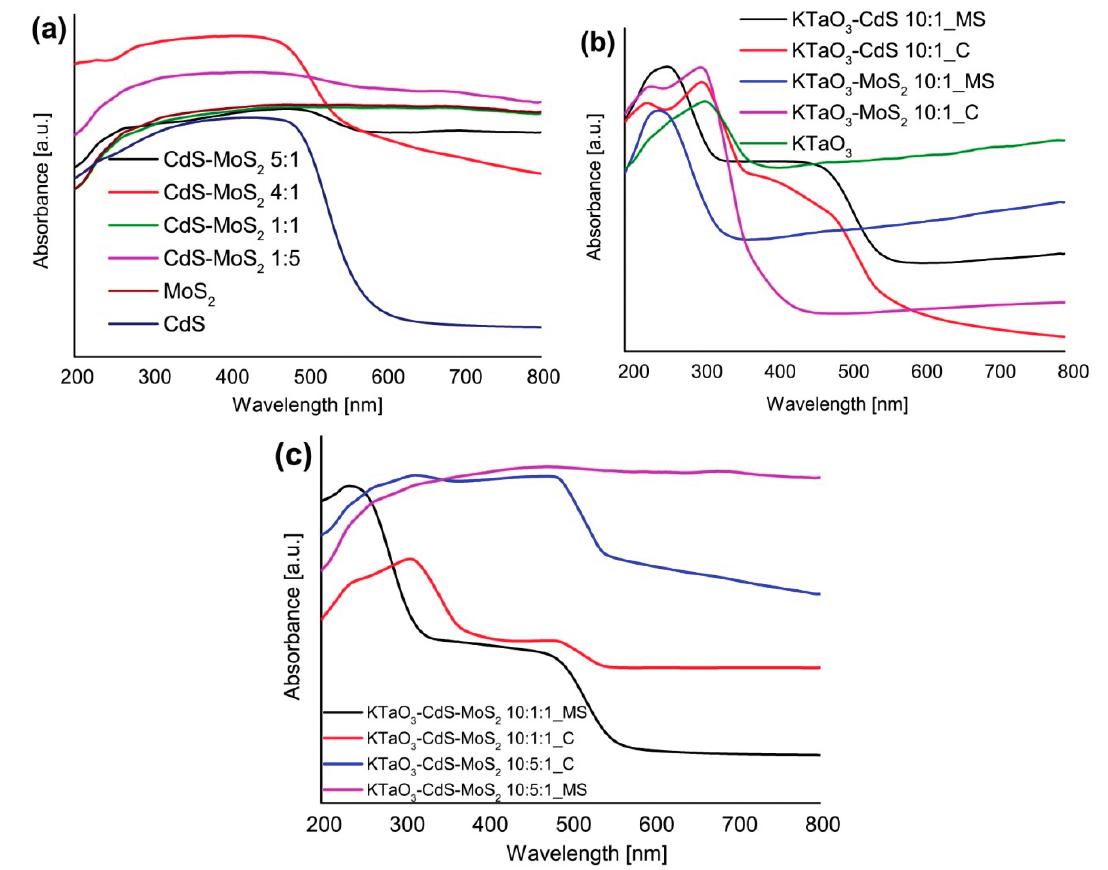
Figure 6. The UV-Vis diffuse reflectance spectra of ( a ) single CdS, MoS 2, and binary CdS-MoS 2 nanocomposites, ( b ) single KTaO 3 and binary KTaO 3 -based nanocomposites, ( c ) ternary KTaO 3 -based